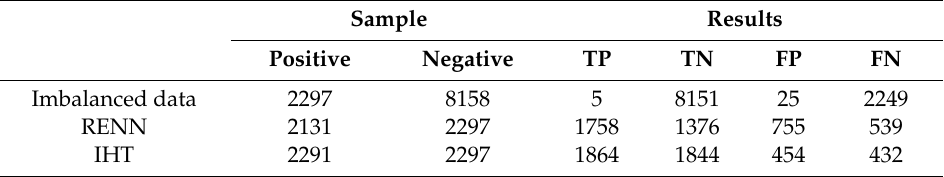
Table 3. Classification results of two sampling methods and imbalance dataset.